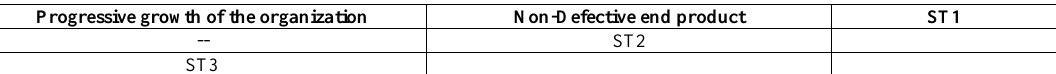
Table 3. Self-interaction interpretive matrix for a situation in interpretive form.